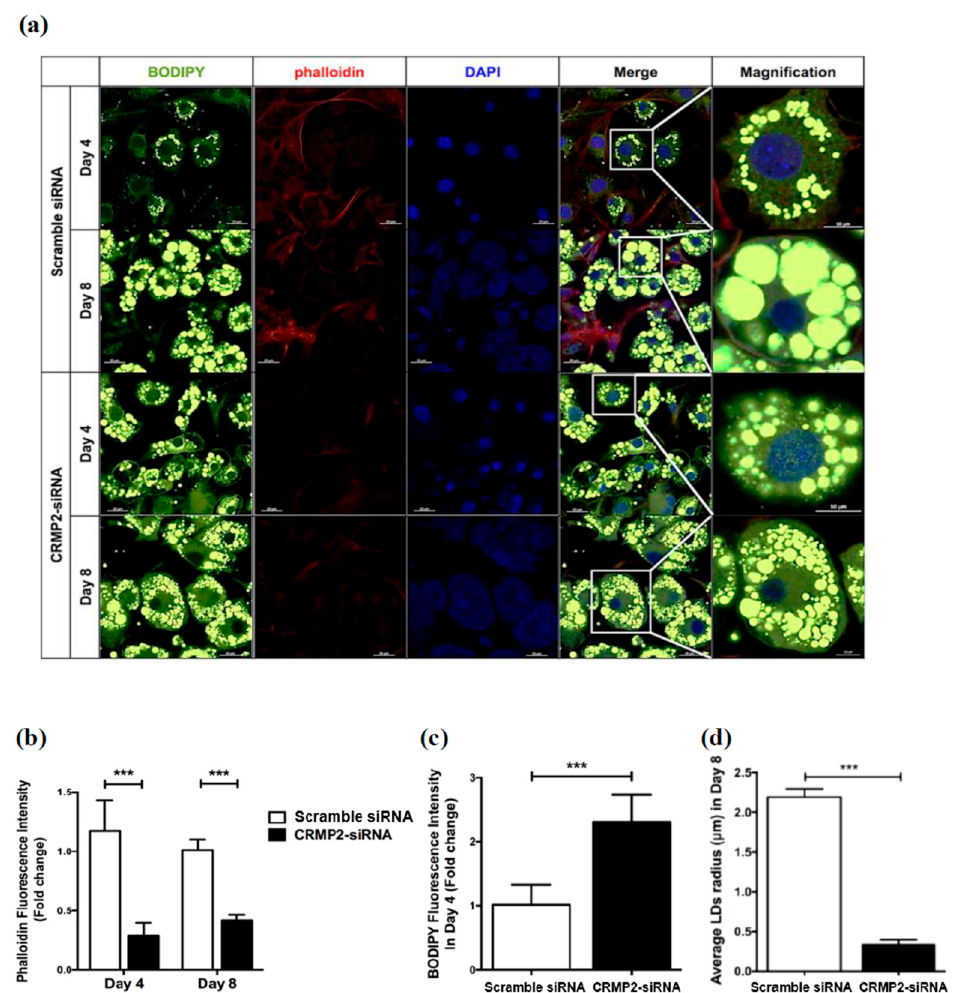
Figure 7. Effects of CRMP2 knockdown on cytoskeleton and lipid droplets. ( a ) Cells were transfected with CRMP2-specific siRNA (CRMP2-siRNA cells) or control siRNA (non-siRNA) on day -2, then subjected to differentiation. Lipid droplets (LDs) and phalloidin-positive actin filaments were detected on day 4 or day 8. ( b – d ) Quantitation of the signals in ( a ). The scale bars represented 20 μ m in regular images and 10 μ m in Magnification, respectively. Data were presented as means ± SEM